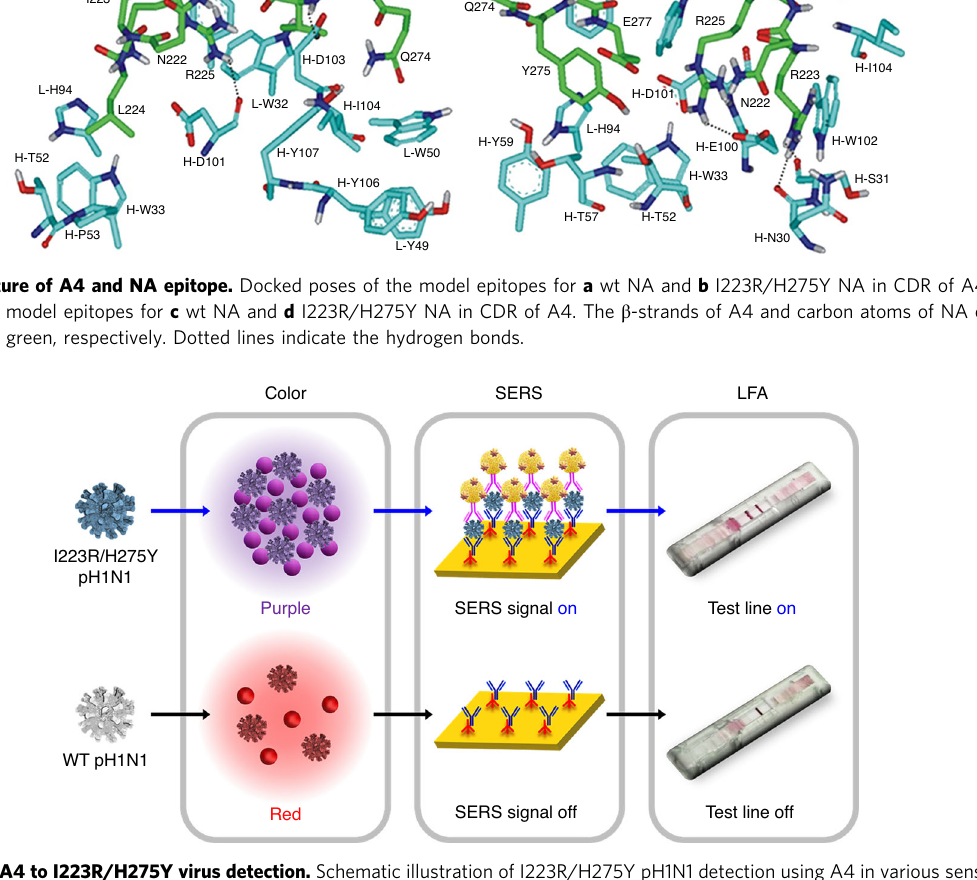
Fig. 4 Application of A4 to I223R/H275Y virus detection. Schematic illustration of I223R/H275Y pH1N1 detection using A4 in various sensing platforms including colorimetry, SERS, and concentrations for quantitative analysis as shown in Fig. 5b. At maximum Abs 580 and Abs 520 , the A4-Au NPs were purple- colored aggregates and red-colored dispersed particles, respec- tively. Thus, as the Abs 580 /Abs 520 value increased, the solution became increasingly purple, indicating more aggregation. The Abs 580 /Abs 520 values exhibited a linear correlation with the I223R/H275Y pH1N1 virus concentration. Even with 10 2 PFU of